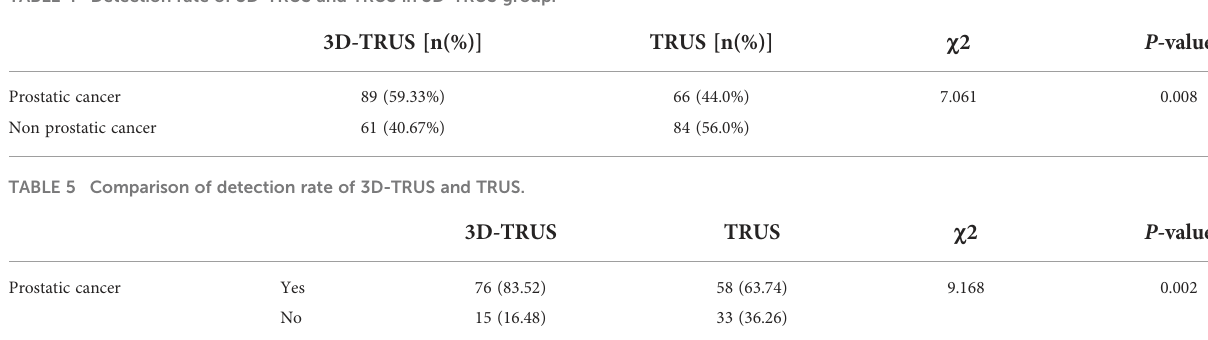
TABLE 4 Detection rate of 3D-TRUS and TRUS in 3D-TRUS group.